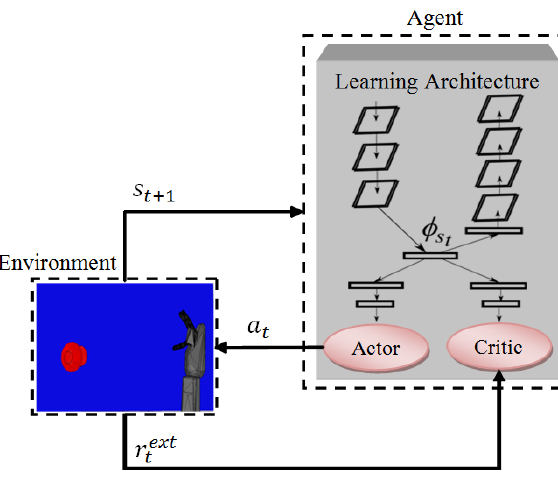
Figure 2: Deep CACLA learning system: The convolutional encoder